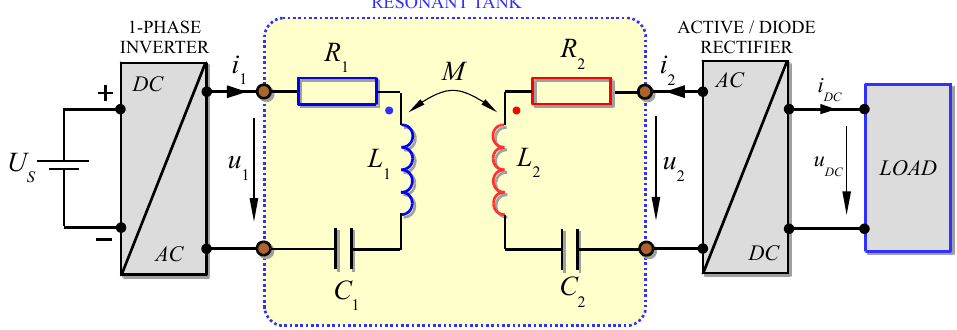
Figure 1. Block diagram of the investigated wireless power transfer (WPT) charging system.